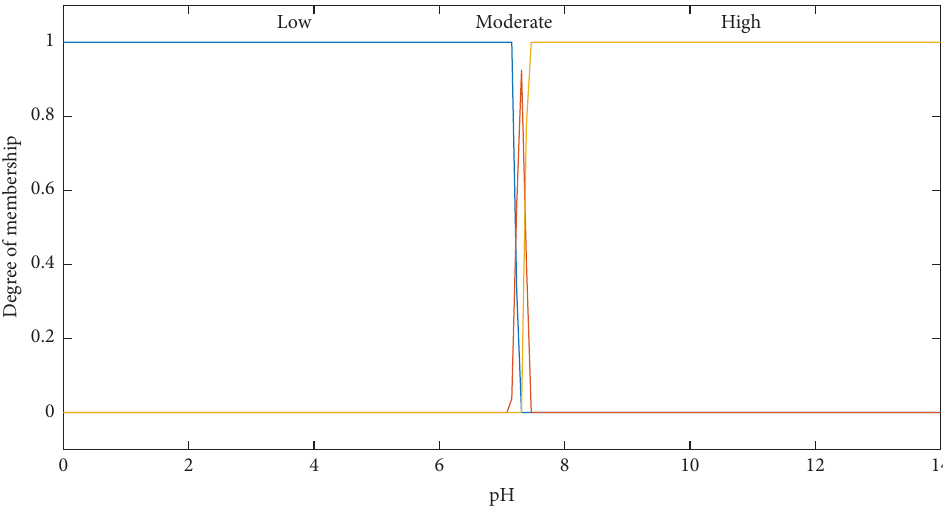
Figure 12: Membership function for pH input. Table 10: Comparison between physician-based Berlin low PEEP Table 9: Comparison between physician-based Berlin high PEEP defnition and fuzzifed Berlin low PEEP defnition and fuzzifed Berlin high PEEP defnition.